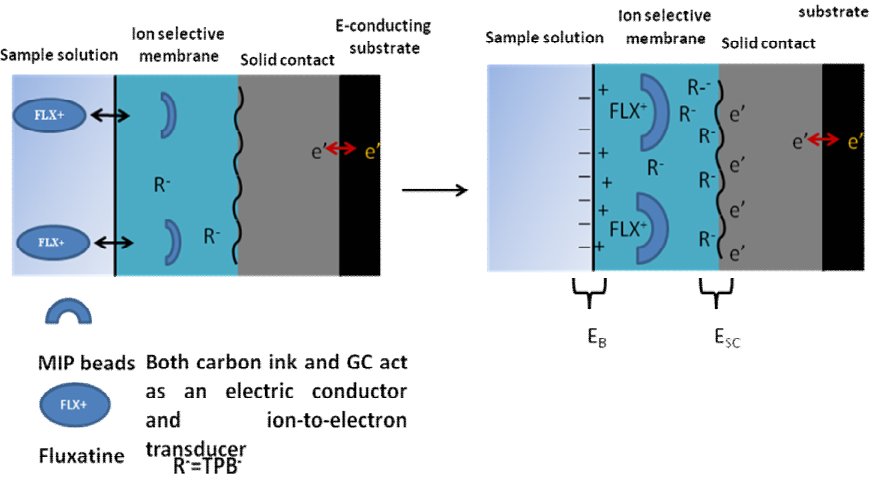
Figure 6. Proposed mechanism for potential development. Table 1. The potentiometric response of the fluoxetine (FLX) membranes sensor.